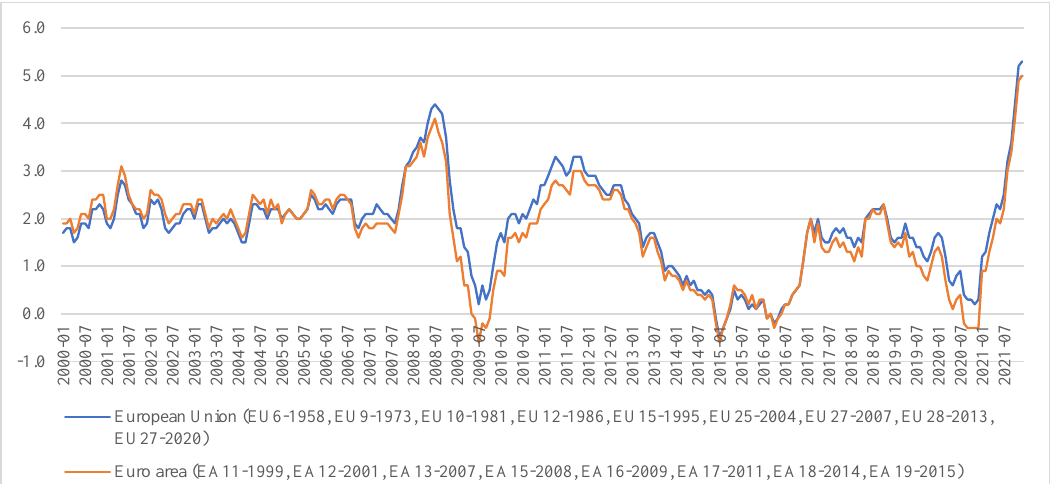
Figure 2. Annual Inflation Rate (in %). Source dataset: Eurostat (2). Inflationary pressures were dramatically increased by a sharp rise in the price of nat- ural gas and electricity, which was very quickly reflected in the production prices of for- eign trading partners. As a result, the contribution of energy to the Euro area ’s total infla- tion as of 12/2021 was 2.46 pp, of which the fuel item with an impact on headline inflation of 0.96 pp had the largest share, followed by electricity with an effect of 0.65 pp and nat- ural gas with an effect of 0.54 pp (see Table 1). Table 1. Contributions to the Euro Area Annual Inflation Rate (pp), Selected Aggregates. COICOP